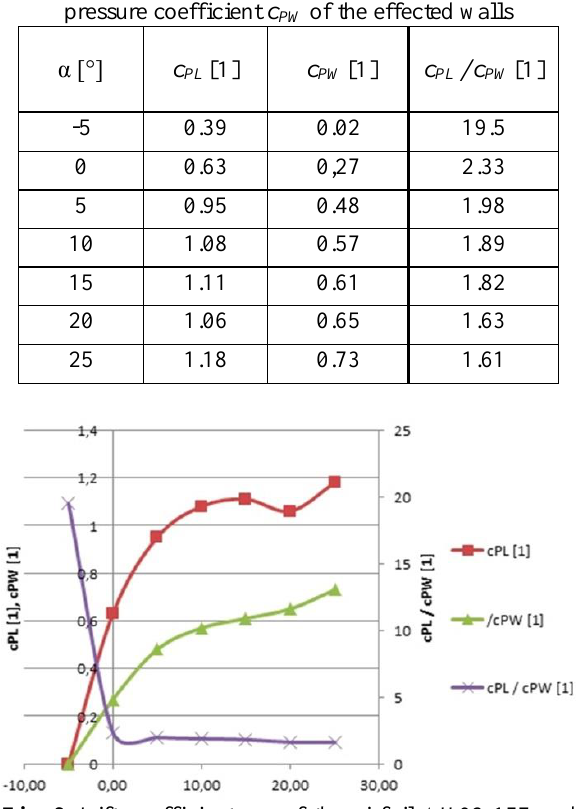
Table 1. Lift coefficient c PL of the airfoil AH93-157 and